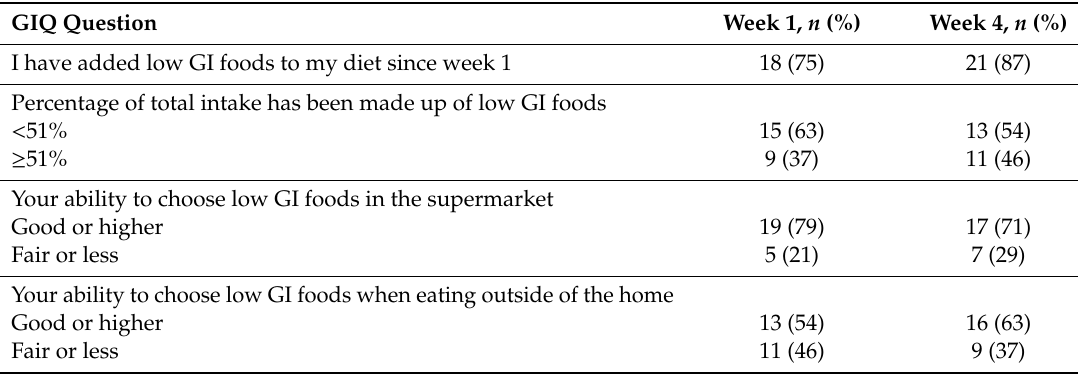
Table 3. Application and acceptability of the glycemic index education postintervention (GIQ Section 4). GIQ